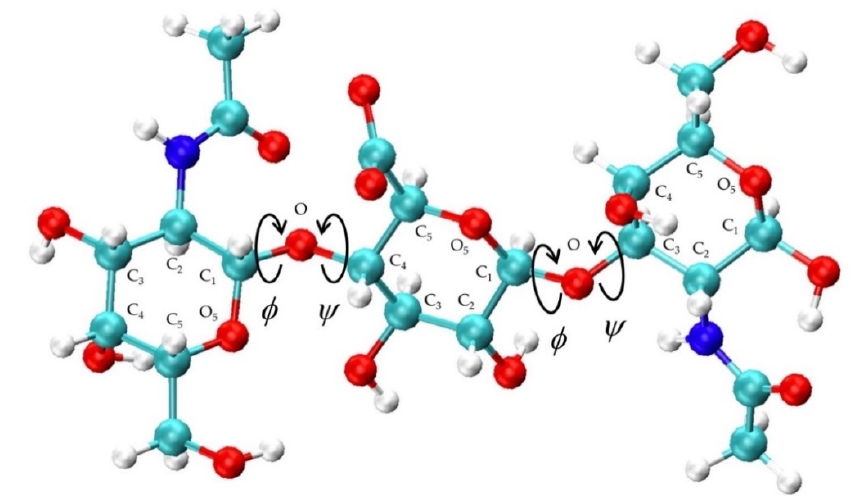
Figure 2. Non ‐ sulfated chondroitin trisaccharide with glycosidic linkage dihedral angles, monosaccharide ring atoms, and linker oxygen atoms labeled; glycosidic linkage parameters used in and  = O 5 ‐ C 1 ‐ O ‐ C n and  = C 1 ‐ O ‐ C n ‐ C ( n − 1) dihedral